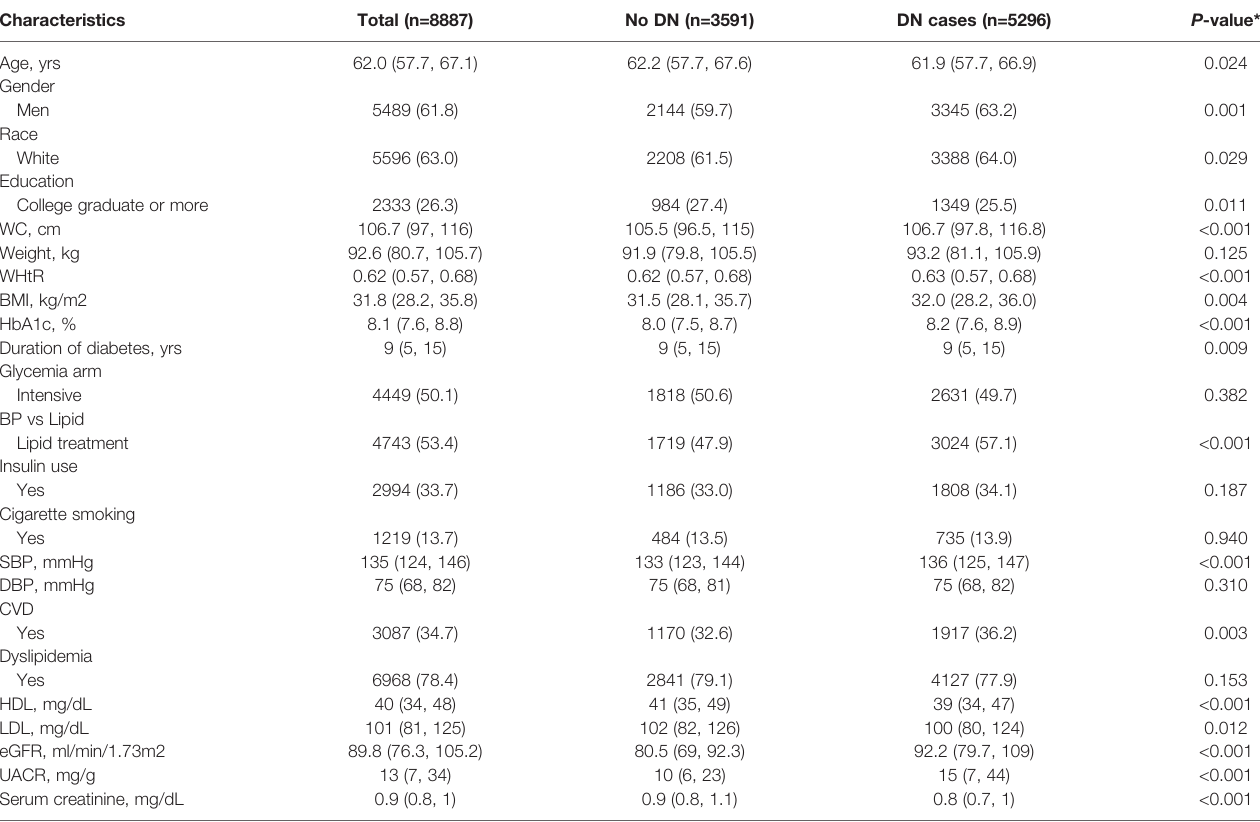
TABLE 1 | Baseline characteristics strati fi ed by subjects who subsequently developed DN and those who did not, after adjusting for age and sex.